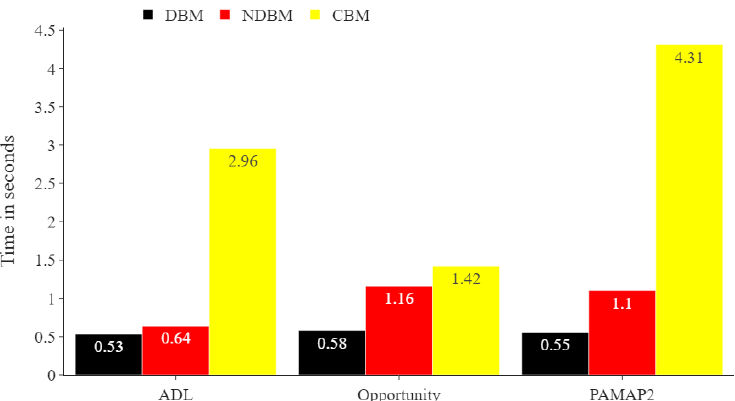
Figure 8. Comparing run times in seconds of the proposed DBM and CBM for all training datasets. The number of samples in the training sets for the ADL, Opportunity, and PAMAP2 datasets were 11,776, 1569, and 6450,